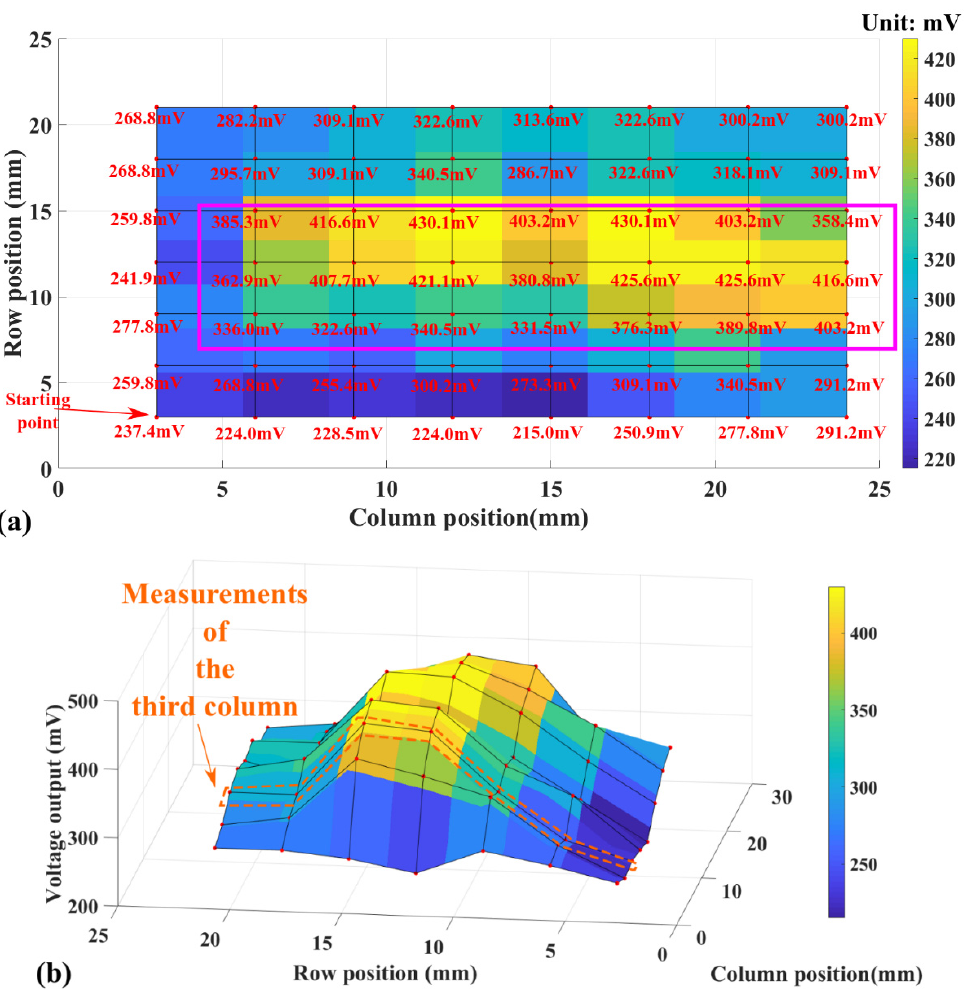
Figure 12. Voltage readout mapping to the area scanning of palpations on a self-made tissue phantom. ( a ) 2D view of the measurement result, ( b ) 3D view of the measurement result .